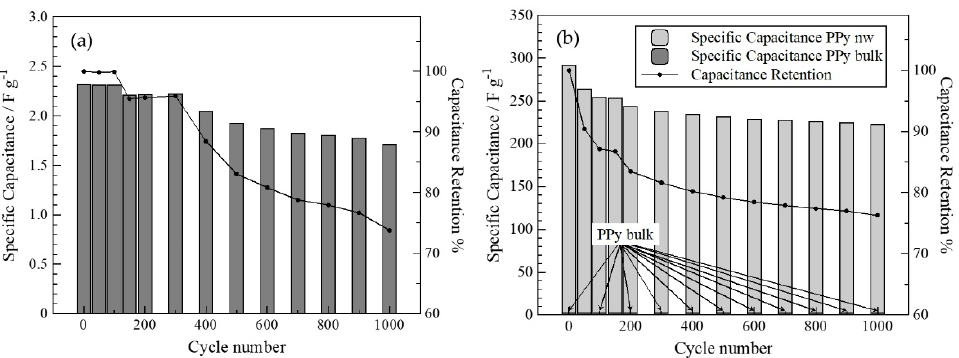
Figure 3. Graphic representation of specific capacitance and % of capacitance retention vs. number of charge/discharge cycles obtained in galvanostatic measurements in 0.1 mol · L − 1 LiCl for 1000 cycles: ( a ) PPy bulk, and ( b ) PPy ‐ nw.